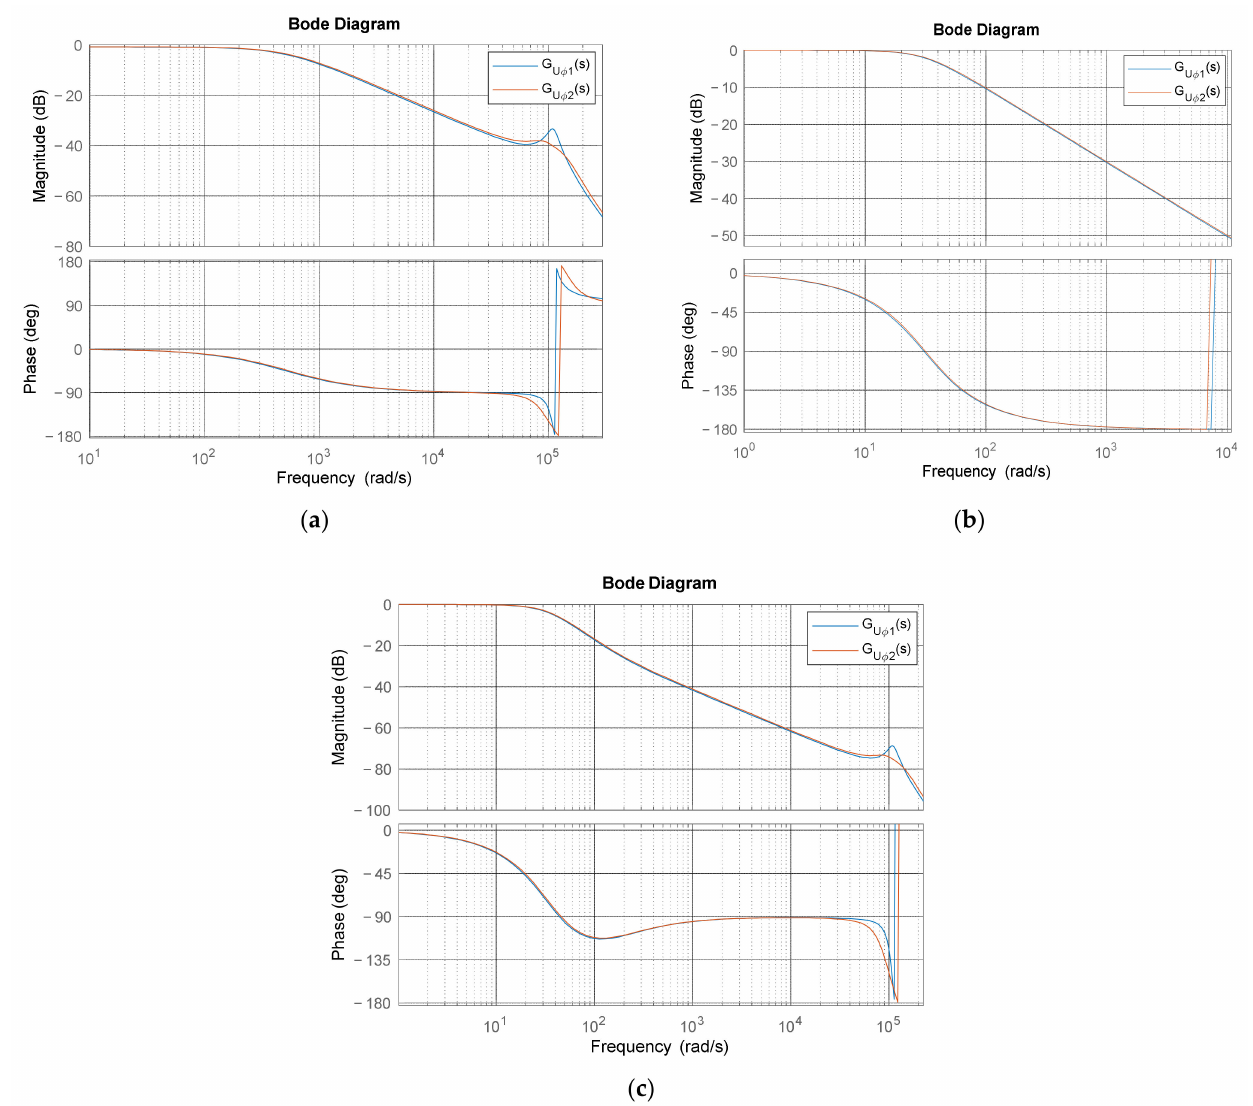
Figure 9. Closed-loop Bode plot of the IPT system using double DD coils and a voltage controller. ( a ) P controller, ( b ) I controller, ( c ) PI